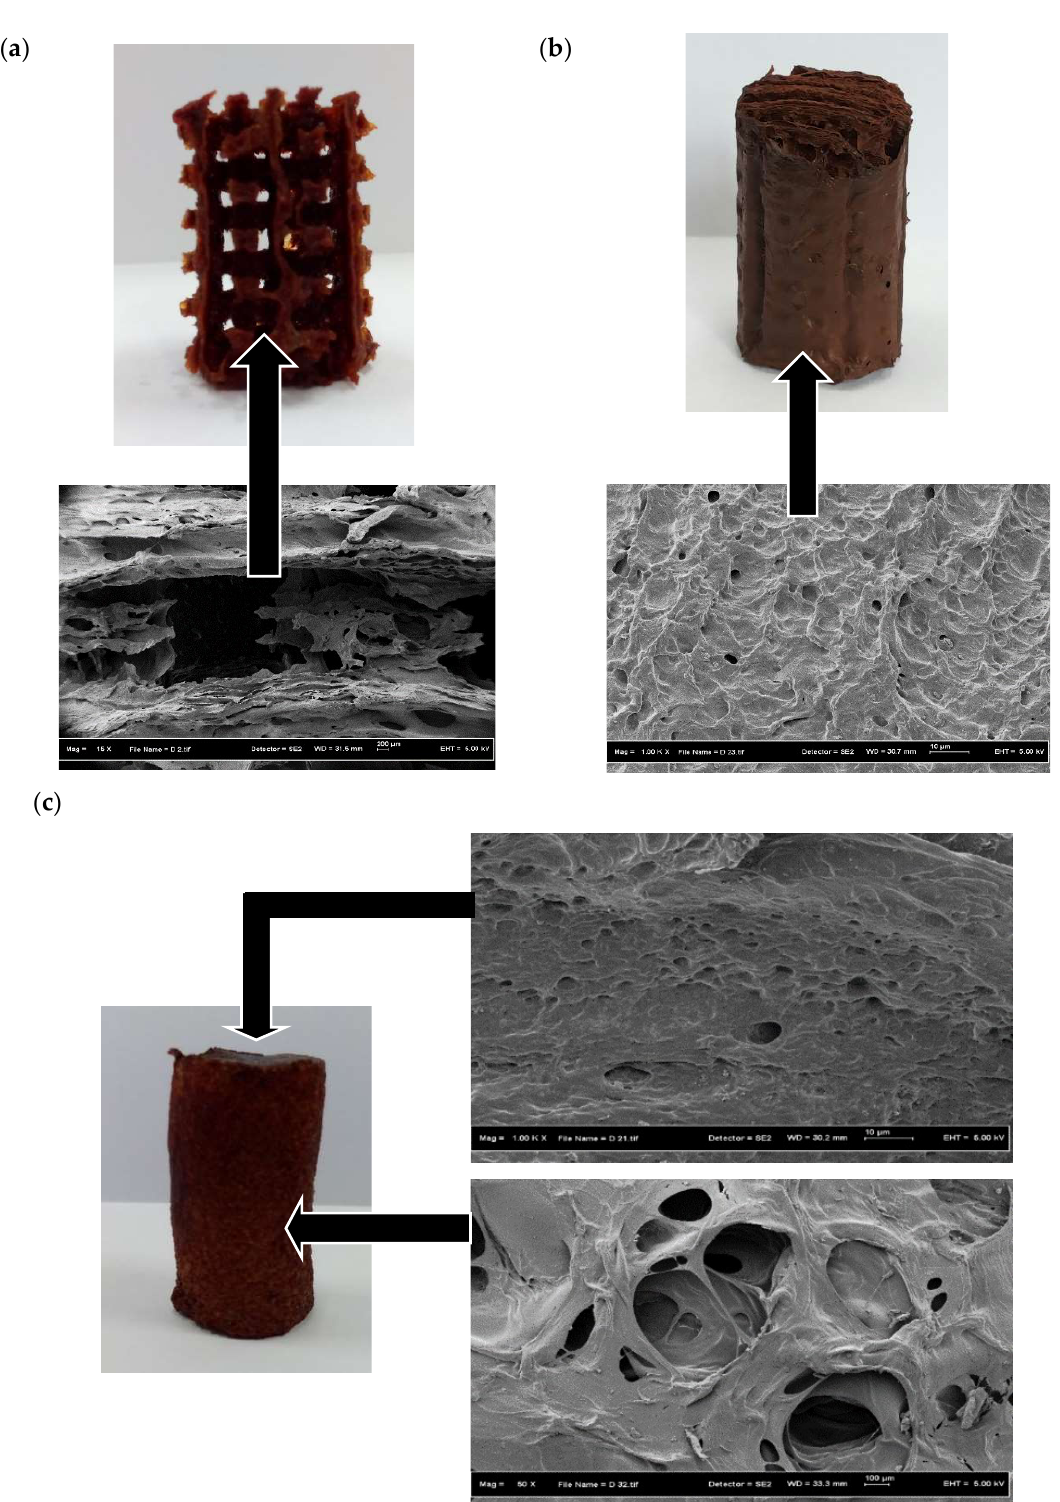
Figure 5. Morphology of the 3D construct: ( a ) without wall; ( b ) with thin wall; and ( c ) control specimen prior to electrospinning.